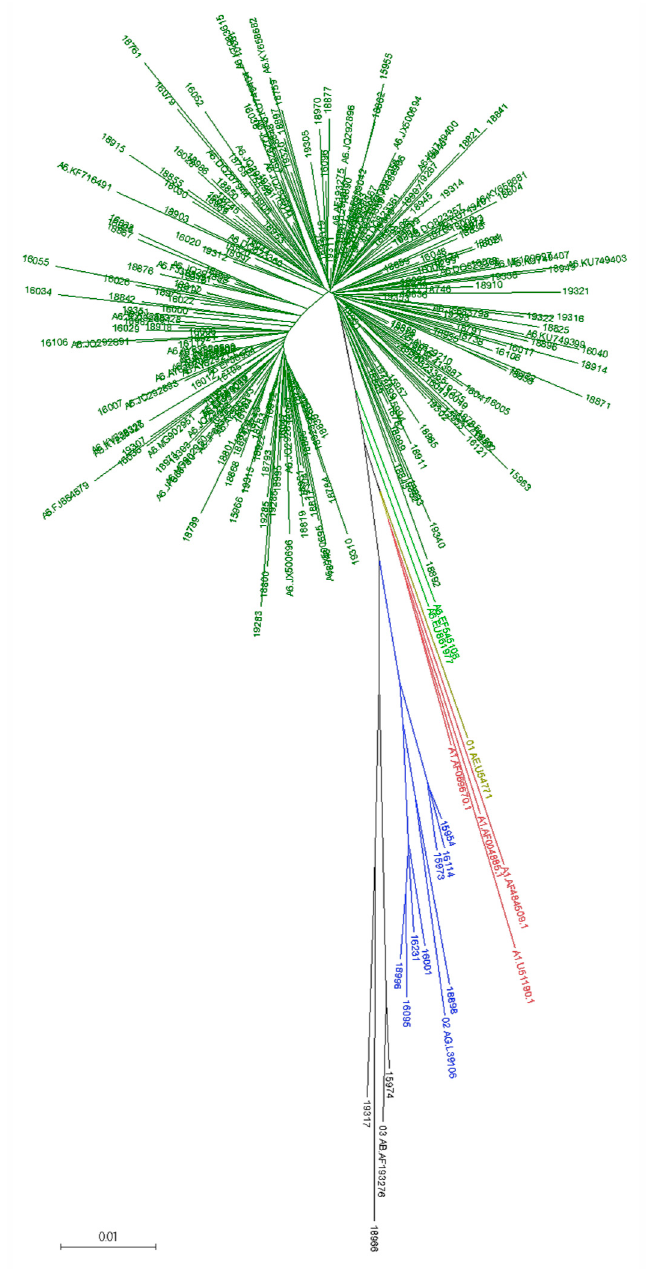
Figure 2. Neighbour-joining (NJ) tree for the identification of A6 samples. Samples EF545108 and EU861977 are highlighted in lime green.